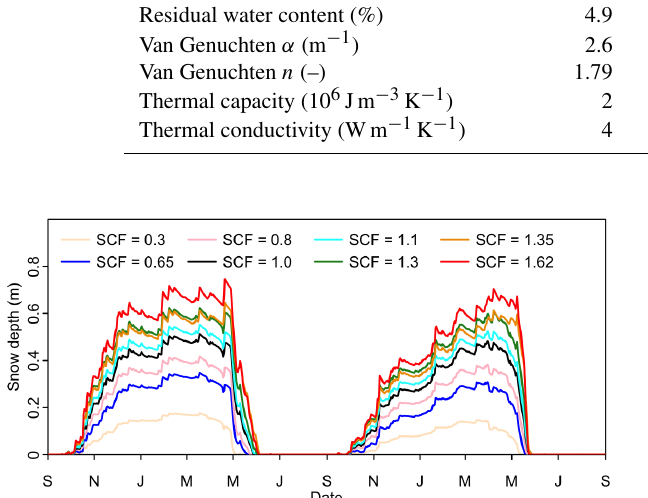
Figure 6. Simulated ensemble mean daily snow depth using dif- ferent snow correction factors (SCFs) to reproduce the snow melt- out date for terrain types during the period September 2015– August 2017. Max is the maximum snow depth during the measured period in